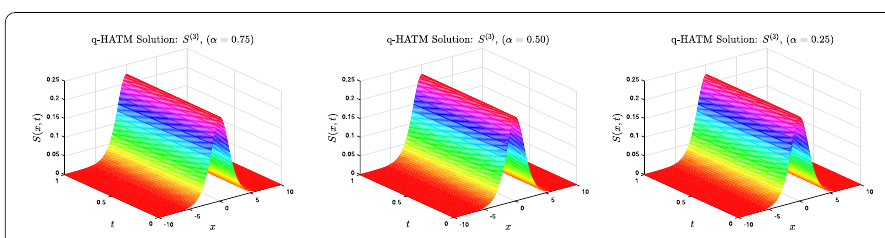
Figure 14 q-HATM S (3) -solutions with different α when (cid:2) = –1, A = r = 0.1, B = 3, and n = 1 for Example 4.3